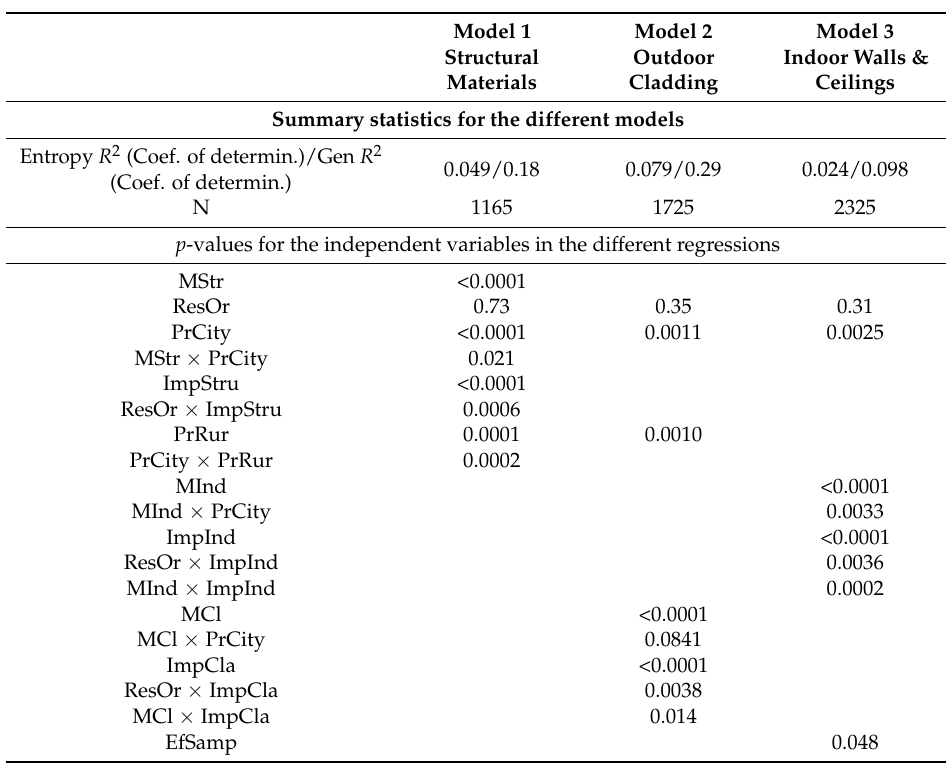
Table 3. Statistics for the multiple logistic